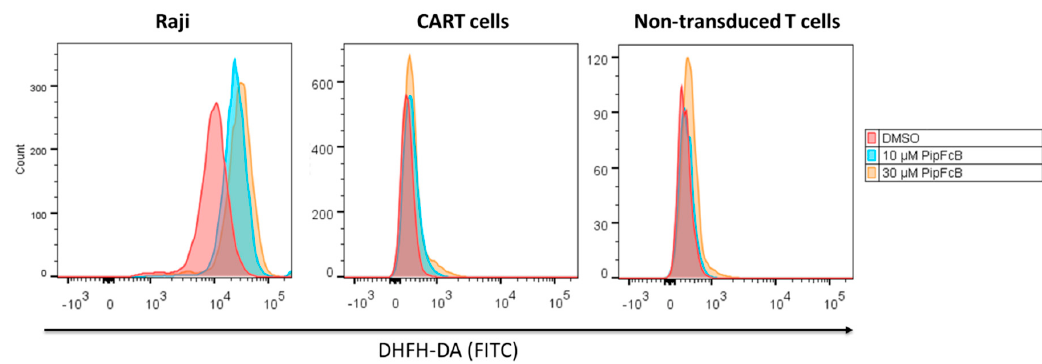
Figure 7. Generation of oxidative stress by PipFcB in malignant lymphoma cells, as well as CARTs and non-transduced T cells. After staining with Dichloro-dihydro-fluorescein diacetate (DCFH-DA), Raji cells—as well as CARTs and non-transduced T cells—were incubated with 10 µM or 30 µM PipFcB for four hours. DMSO served as solvent control. Raji cells exhibited a significantly higher induction of PipFcB-mediated oxidative stress. Representative histograms of three independent experiments are shown.